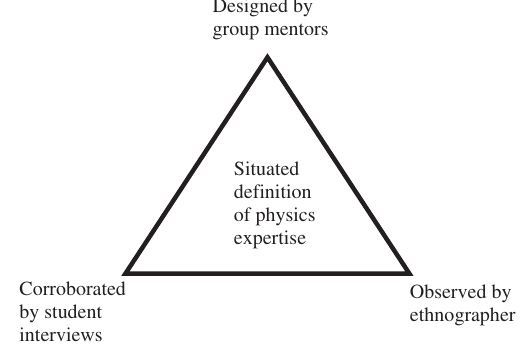
FIG. 1. Diagram representing different sources of data that illustrate the situated definition of physics expert as practiced in the research